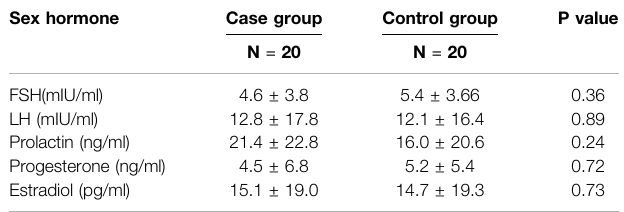
TABLE 2 | Sex hormone levels of the case and control